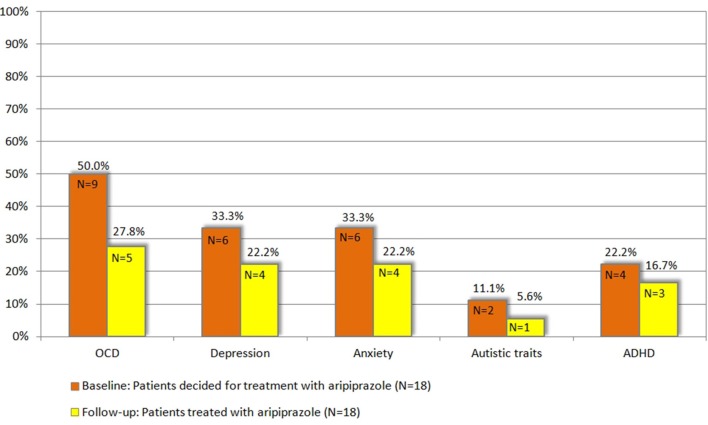
Patients with respective comorbidity at baseline compared to follow-up, N = 18 (for definition of psychiatric comorbidities (OCD, ADHD, depression, anxiety, and autistic traits) refer to chapter 2.3).